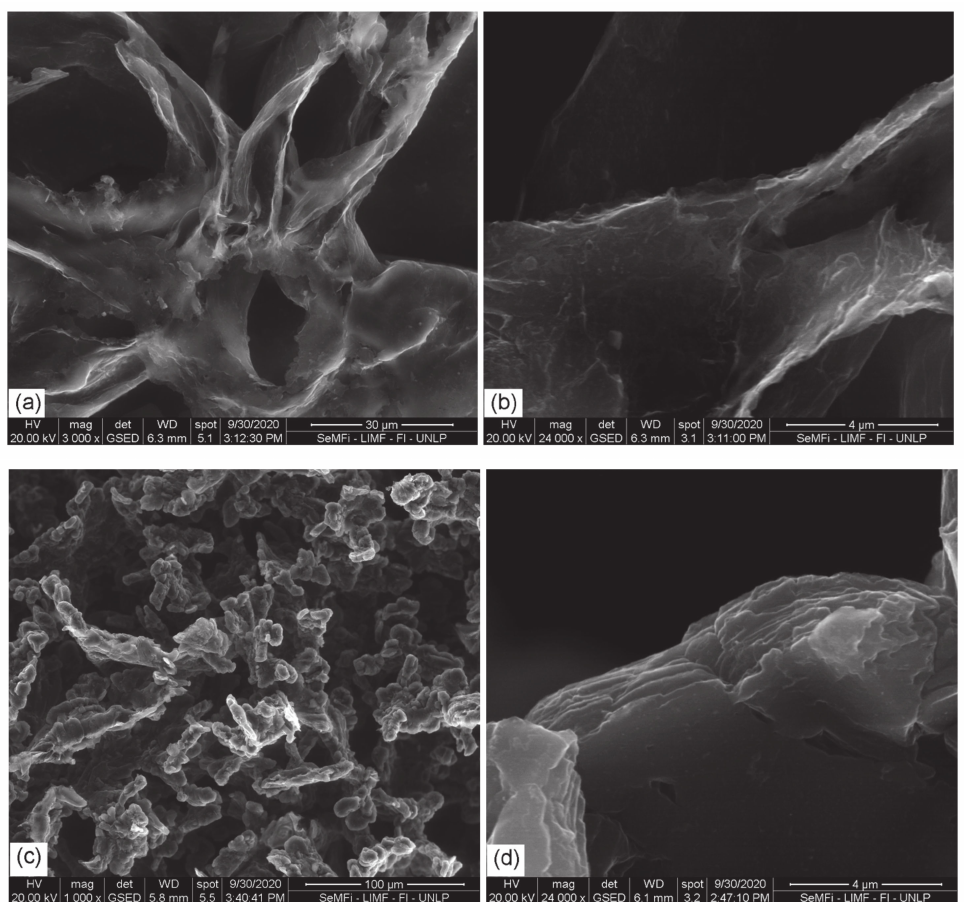
Figure 3. SEM images of AEGs obtained at two different magnifications from: LAG ( a ) and ( b ); compacted graphite (CG) ( c ) and ( d